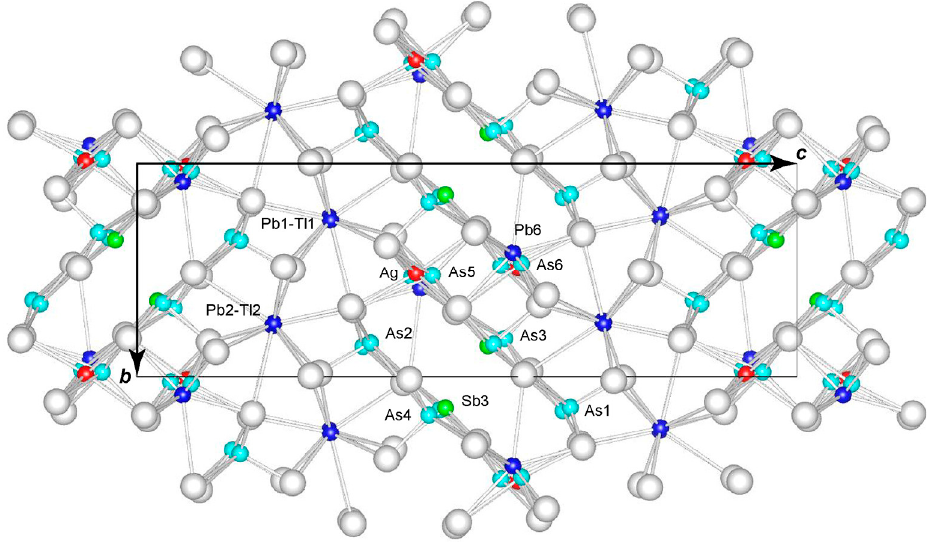
Figure 4. The crystal structure of phase ‘rath7’ (Topa and Kolitsch [34]) with labeled metal positions. White circles represent sulfur atoms.